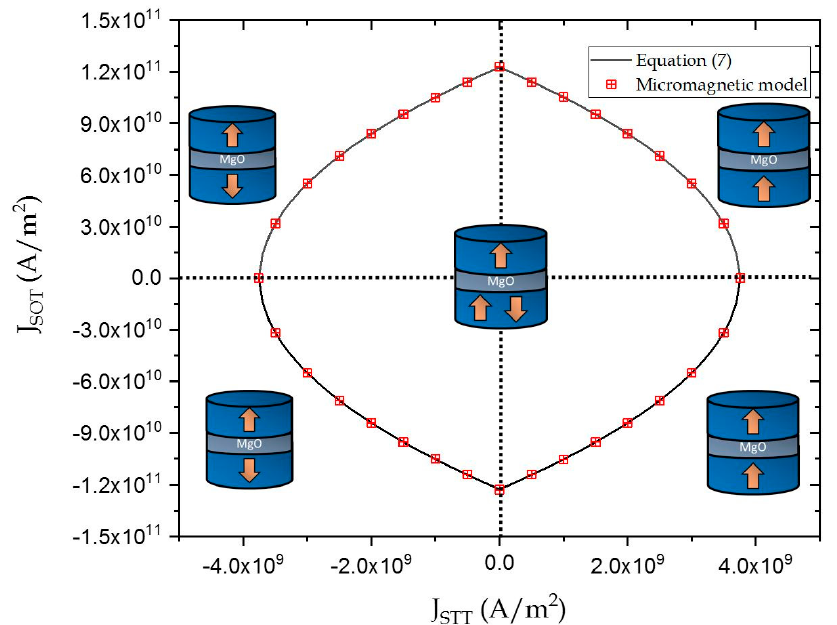
Figure 5. The solid line represents the boundary Equation (7). The symbols represent the results obtained from micromagnetic